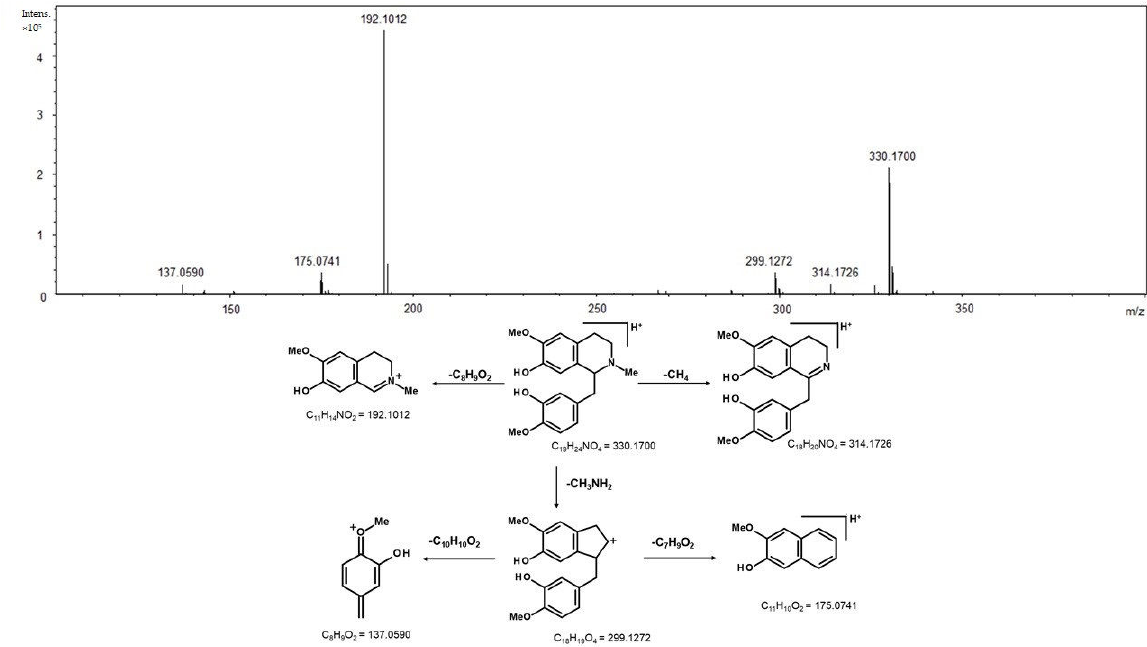
Figure 4. High resolution mass spectrum of reticuline [M + H] + = 330.1700 and its fragmentation